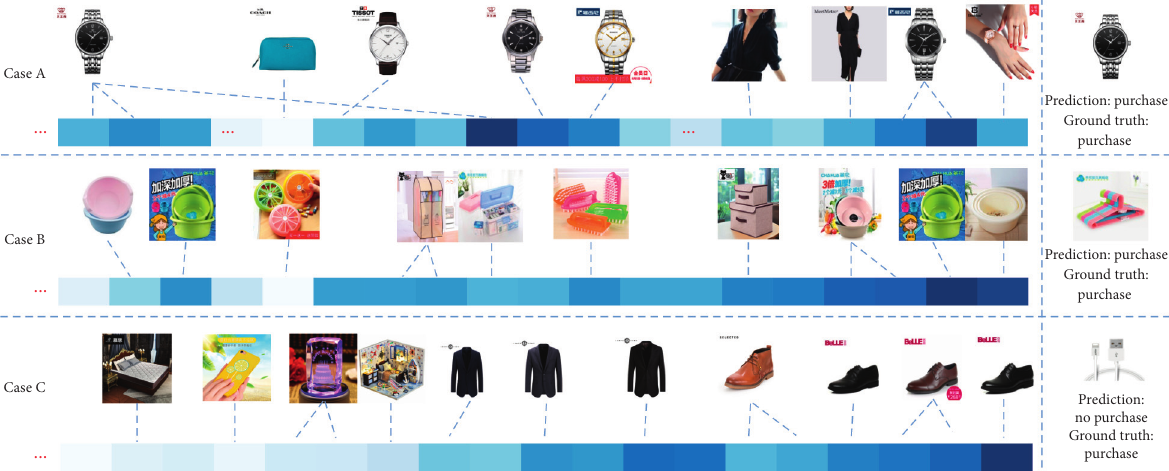
Figure 6: Case study of making prediction whether the user purchases the next item according to historical sequential behaviors. Each case consists of one user’s clicked items ordered by click time and shows the attention heat map for each item and the final item (clicked or purchased) with prediction and ground truth. Darker color in the heat map indicates higher attention